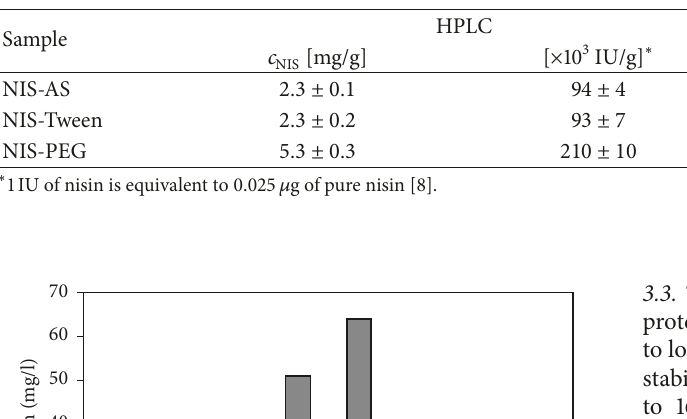
Table 2: Determination of nisin concentration in prepared lyophilisates.